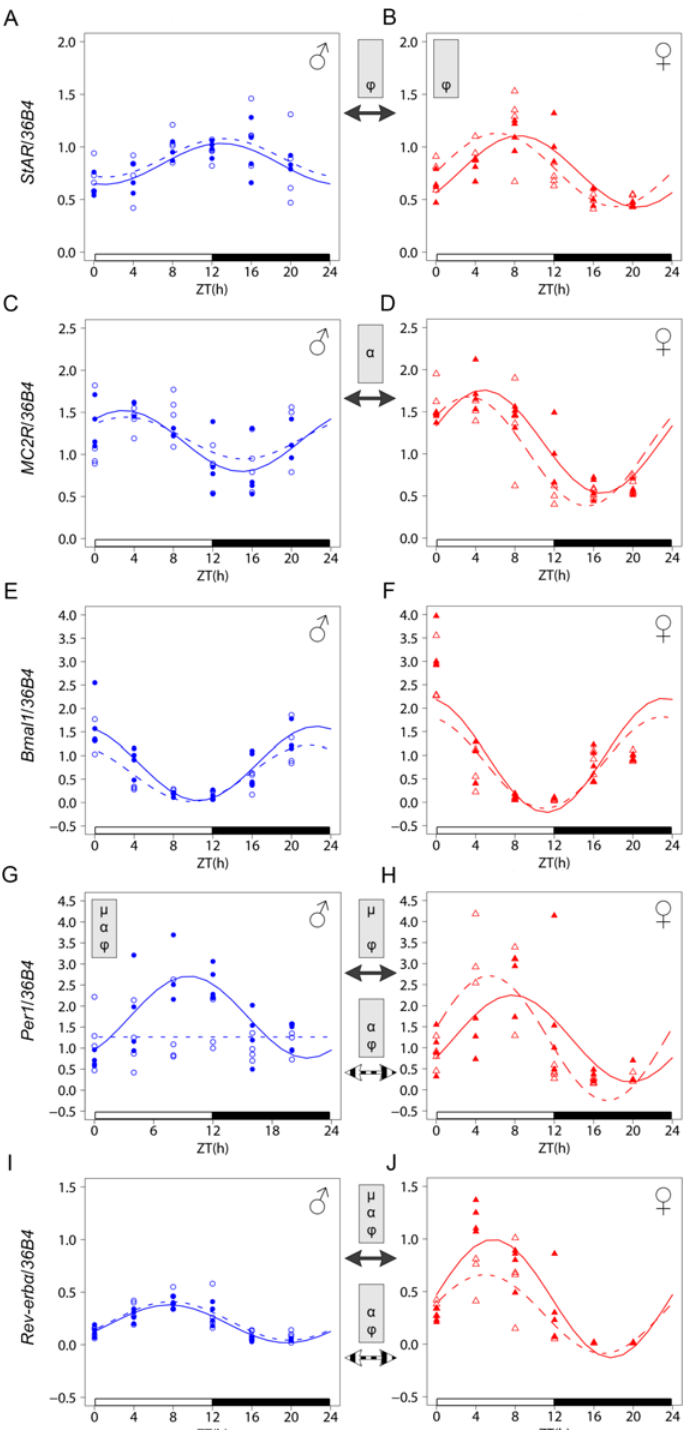
Fig 4. Analysis of circadian gene expression in the adrenals of WT and Lxr α -/- mice. Diurnal mRNA expression of adrenal StAR (A, B), MC2R (C, D), Bmal1 (E, F), Per1 (G, H) and Rev-erb α (I, J) was compared using qRT-PCR in WT (plain line) and Lxr α -/- mice (dashed line). For each time point, 3 – 4 mice were used. Cosinor-based non-linear regression was used for curve fitting. The ZT0 time point is double plotted for visualization purposes. Expression data were normalized to the constitutively expressed 36B4 mRNA. The